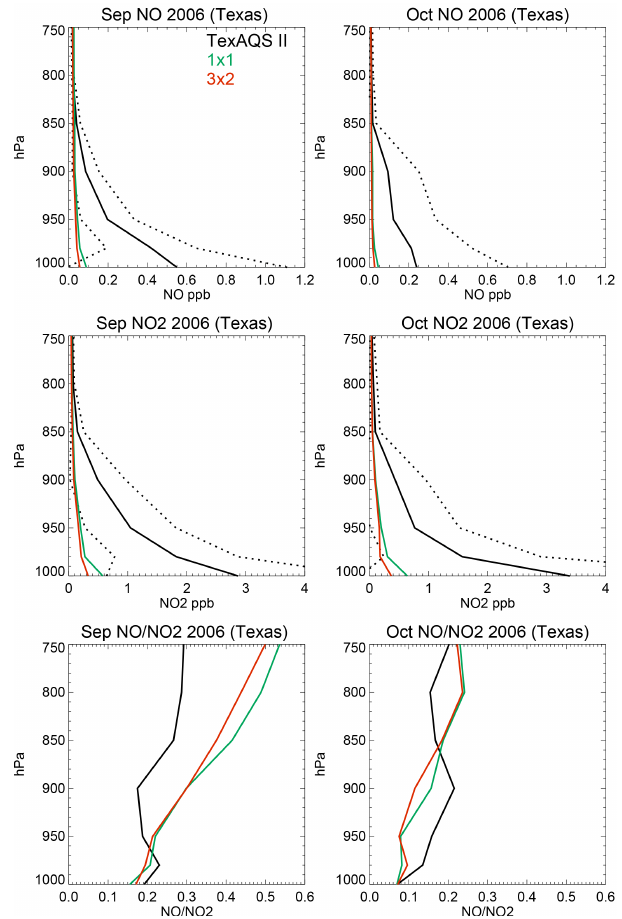
Figure 8. Monthly mean comparisons of NO (left), NO 2 (middle) and the resulting NO / NO 2 ratio (right) from the TexAQSII cam- paign during September and October 2006 and TM5-MP simula- tions. The dotted line represents the 1 σ deviation in the mean of the measurements. For details of the locations for each month the reader is referred to Parrish et al.